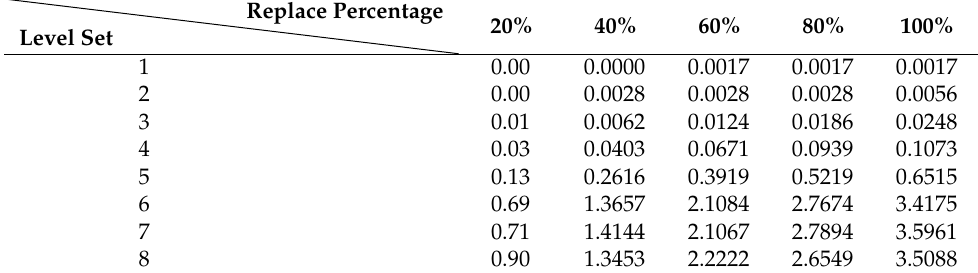
Table 13. Pressure error of substituting the 6th stage.